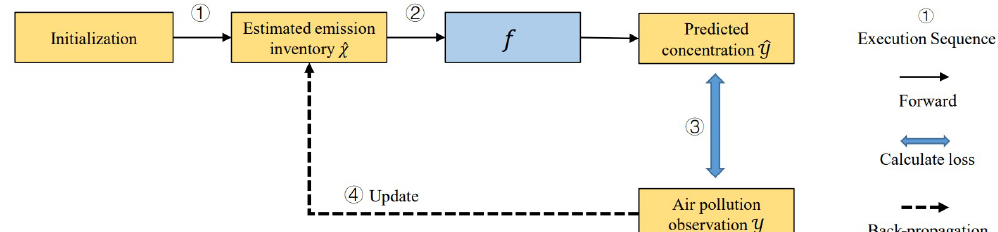
Figure 2. The whole process of emission inventory